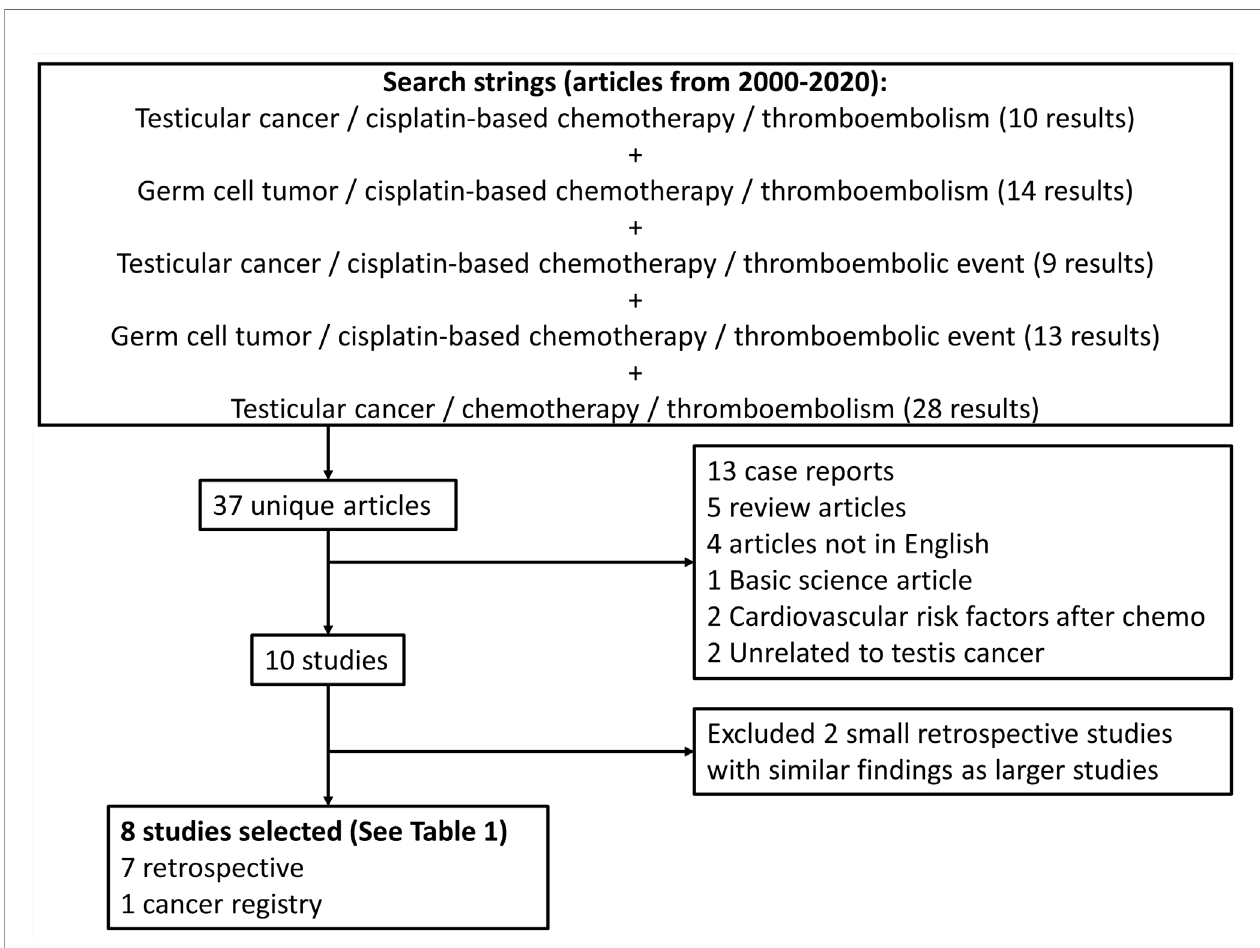
FIGURE 1 | Study fl